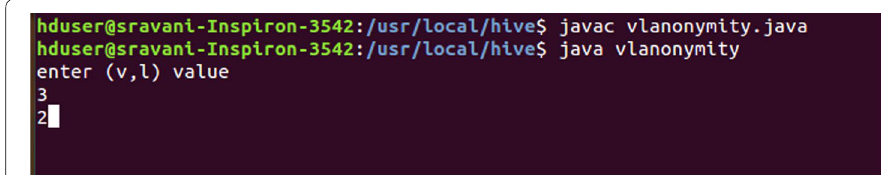
Fig. 7 Accepting key value through vlanonymity.java